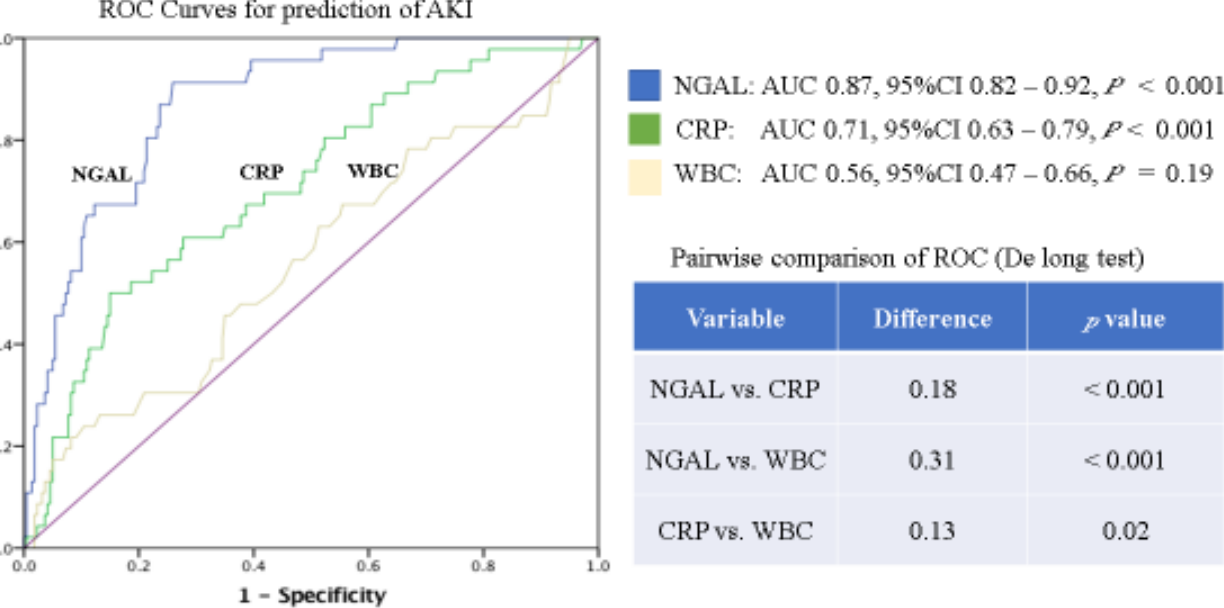
Figure 3. ROC and corresponding AUCs of inflammatory laboratory markers for prediction of the combined endpoint: AKI or MACE; NGAL, neutrophil gelatinase-associated lipocalin; CRP, C-re- active protein; WBC, white blood cells. 4. Discussion The results of this study provide more evidence for the unique value of NGAL in the assessment of cardio–renal interactions. Our results demonstrate that NGAL has an inde- pendent value not only for renal outcomes but additionally may predict concomitant car- diovascular outcomes in acute myocardial infarction. NGAL, a 25-kDa protein covalently bound to gelatinase proteins in human neutro- phils, was reported as an early marker of kidney tubular injury in various patient popu- lations and hence was nicknamed “kidney troponin.” It is released by renal tubular cells in cases of acute tubular damage and may be detected within a few hours of the tubular insult and even in the absence of functional AKI, manifested by serum creatinine elevation [7]. Previous studies have shown the value of serum NGAL for the early diagnosis of AKI